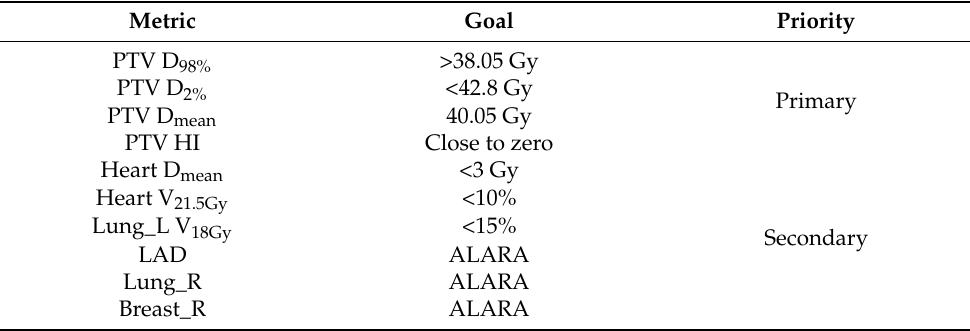
Table A2. Planning goals to the target and organs at risk for h-IMRT and IMPT plans.